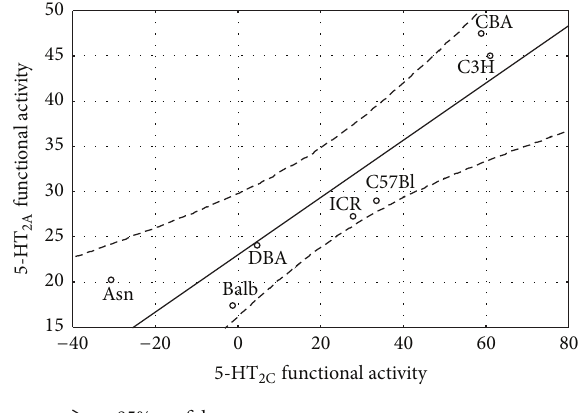
Figure 5: Correlation between 5-HT 2 A and 5-HT 2 C functional responses in seven inbred mouse strains. Correlation was estimated by the Pearson correlation using strain means. Correlation coeffi- cient, 𝑟 = 0.898